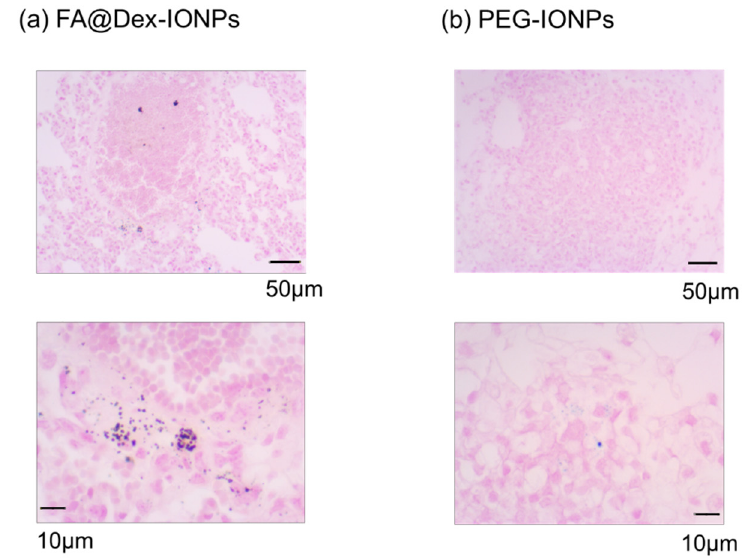
Figure 5. Representative examples of microphotographs of Prussian Blue nuclear fast red staining histology slides obtained from the FA@Dex-IONPs LC ( a ) and PEG-IONPs LC mice ( b ).